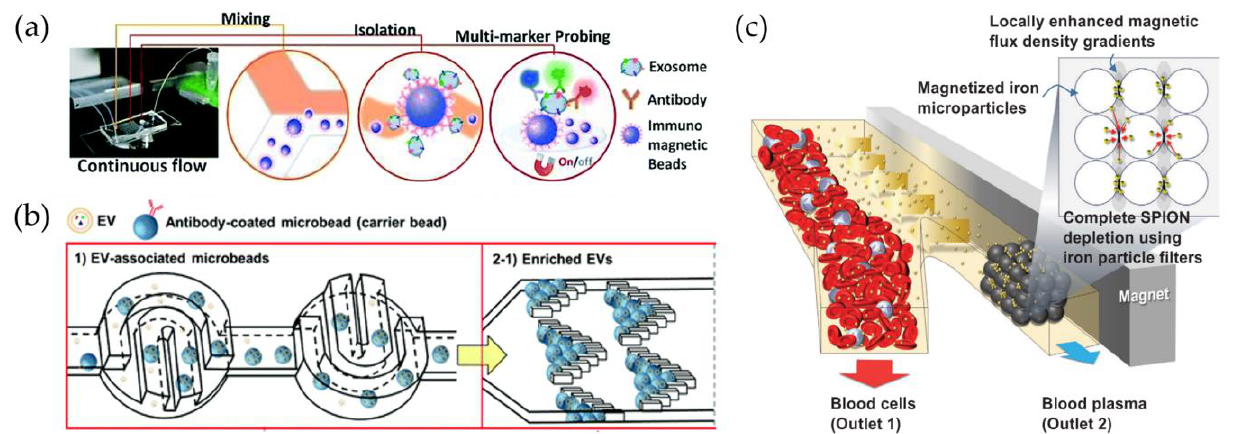
Figure 6. Functionalized beads or nanoparticles used for vesicle capture inside microfluidic devices. ( a ) Immunomagnetic beads coated for the enrichment of vesicles from blood plasma inside ExoSearch chips [126]; ( b ) streptavidin-coated polystyrene beads used as substrate to trap vesicles in herringbone filters and redisperse them [137]; ( c ) microfluidic systems used to flow blood samples and isolate vesicles by means of superparamagnetic nanoparticles (SPIONs), modified from [138].